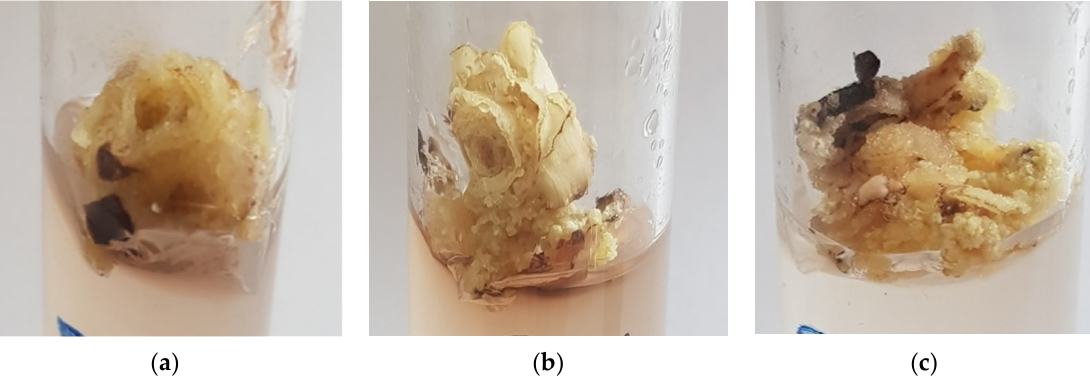
Figure 6. Callus of NSG-59 on MS + 4 mgL − 1 2,4-D + 0.5 mg/L Kinetin after 10 ( a ), 20 ( b ), and 30 ( c ) days of inoculation (2 × ).